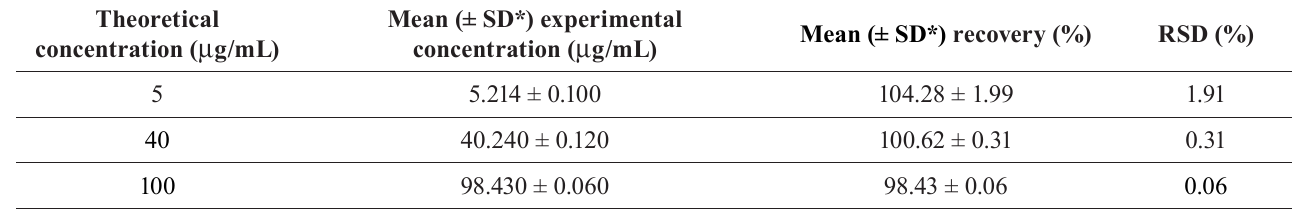
TABLE II – Repeatability for different concentrations of standard ACA solutions Theoretical concentration ( µ g/mL)